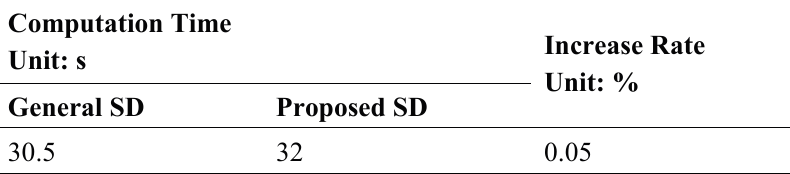
Table 14. Computational load